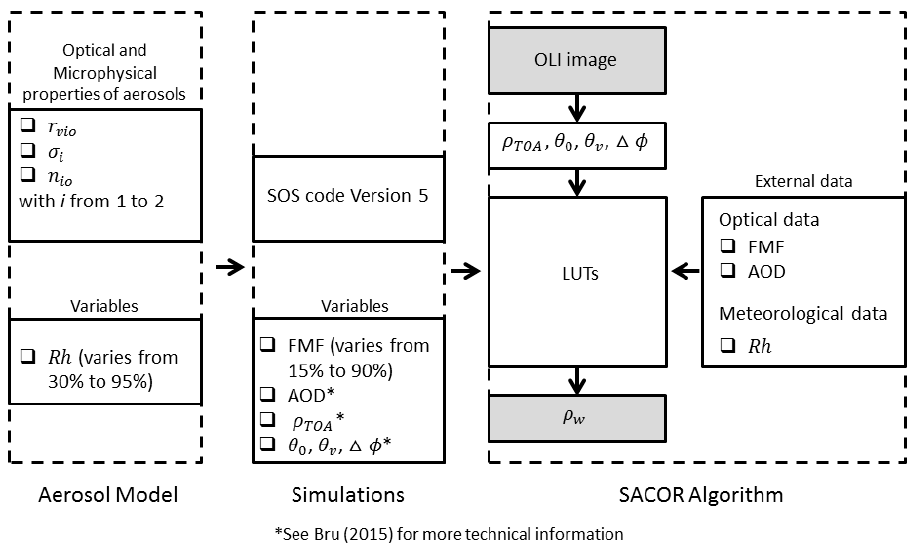
Figure 2. Schematic representation of the in Situ-based Atmospheric CORrection (SACOR) algorithm.